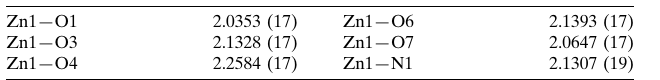
Selected bond lengths (A˚ ).